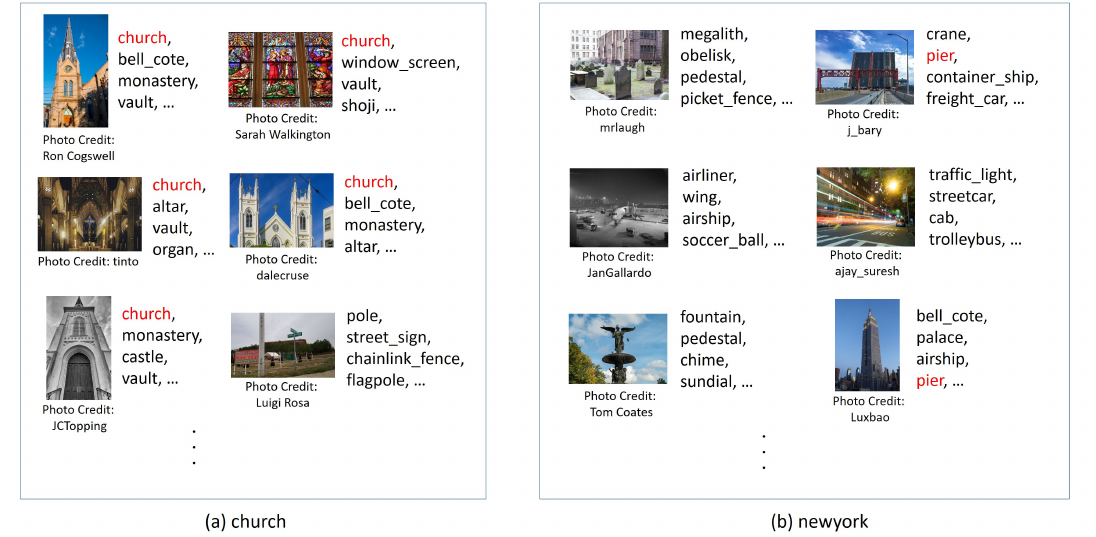
Figure 4. Examples of how the top categories predicted by CNN for each image in I p are used to determine if w p represents a visual concept. ( a , b ) each shows an example for visual concepts and non-visual concepts. The most frequent category predicted for each concept is shown in red. When M is set to 10, the 10 most frequent categories for ( a ) are church , monastery , bell_cote , vault , palace , dome , castle , altar , barn , and tile_roof , which filter out the bottom right image as irrelevant